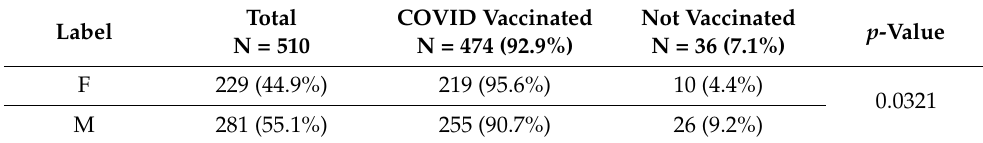
Table 1. Total number and percentage of vaccinated and non-vaccinated HCWs.